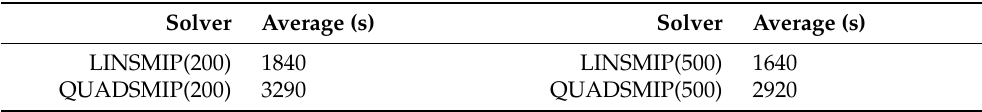
Table 7. Improved solve times for LINSMIP( P ∆ ) and QUADSMIP( P ∆